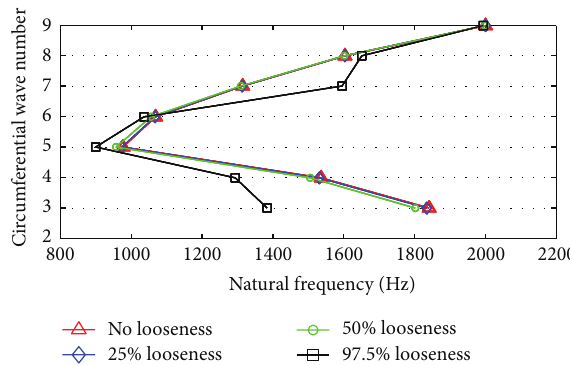
Figure 6: The relation between natural frequency and mode shape under BLB with different looseness